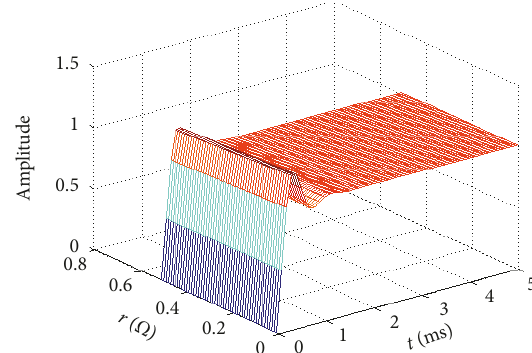
Figure 9: Single update PWM system response to unit step change with the constant sampling frequency f when the resistance r changes.